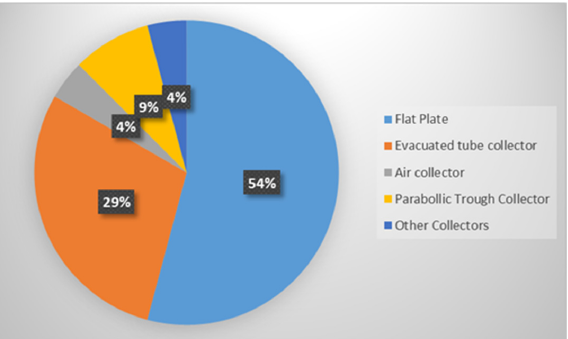
Table 6. SHIP plants in mining industry with process-level integration [25,71]. Figure 13. Percentage of applied solar collectors in the Textile and Leather Industry [71].